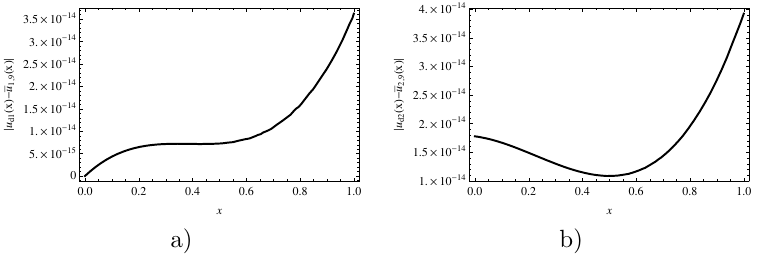
Figure 4. Distribution of error of the exact solution approximation for n = 9